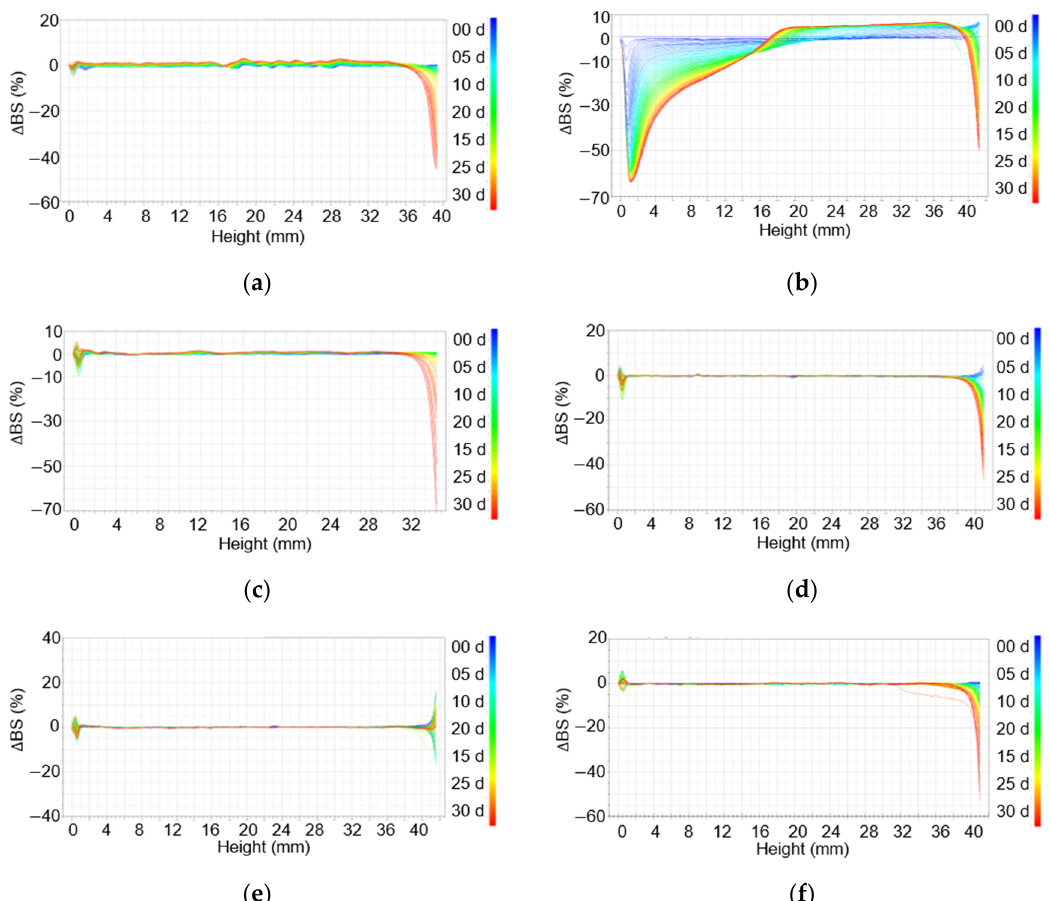
Figure 4. Delta backscattering of emulsions stored at 45 ◦ C for a month: ( a ) Xanthan gum (1.0 wt%), ( b ) Carbopol 981 (1.0 wt%), ( c ) TR-2 (0.5 wt%), ( d ) TR-2 (0.25 wt%), ( e ) Ultrez 20 (0.5 wt%), and ( f ) Ultrez (0.25 wt%).